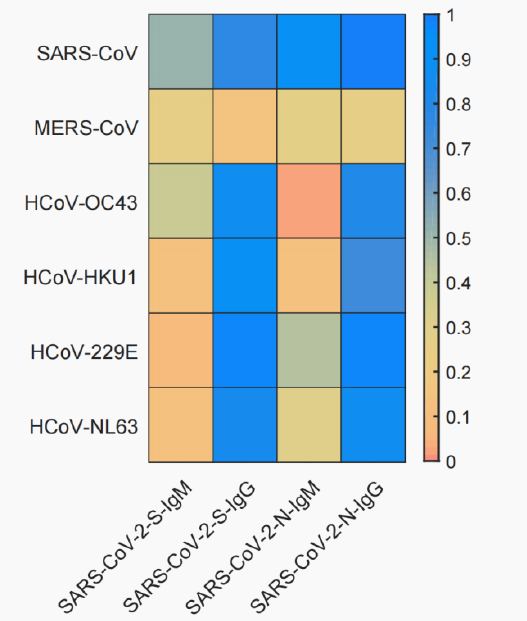
Figure 1. Cross-reactivity of antibodies with six other coronaviruses. The crossover rate was calcu- lated using the actual number of serum specimens involved in the assay as the denominator and the number of positive specimens detected as the numerator.